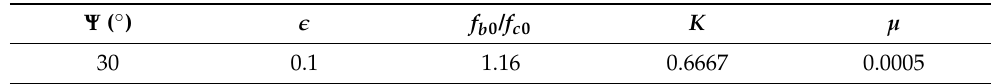
Table 4. Material parameters in the concrete plastic damage model.